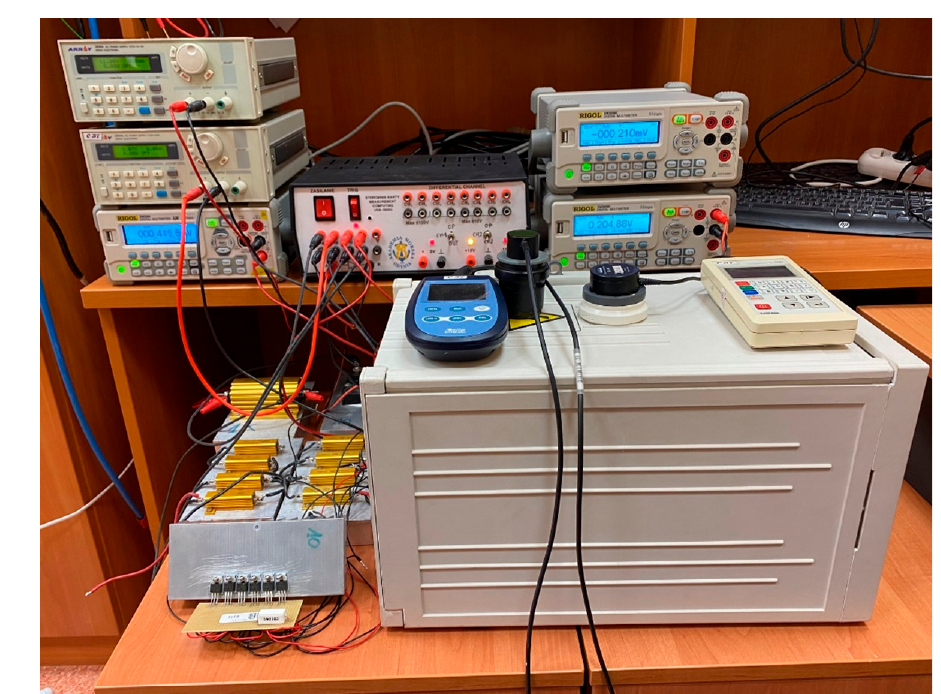
Figure 6. The view of the measurement set-up of the diagram in Figure 5.